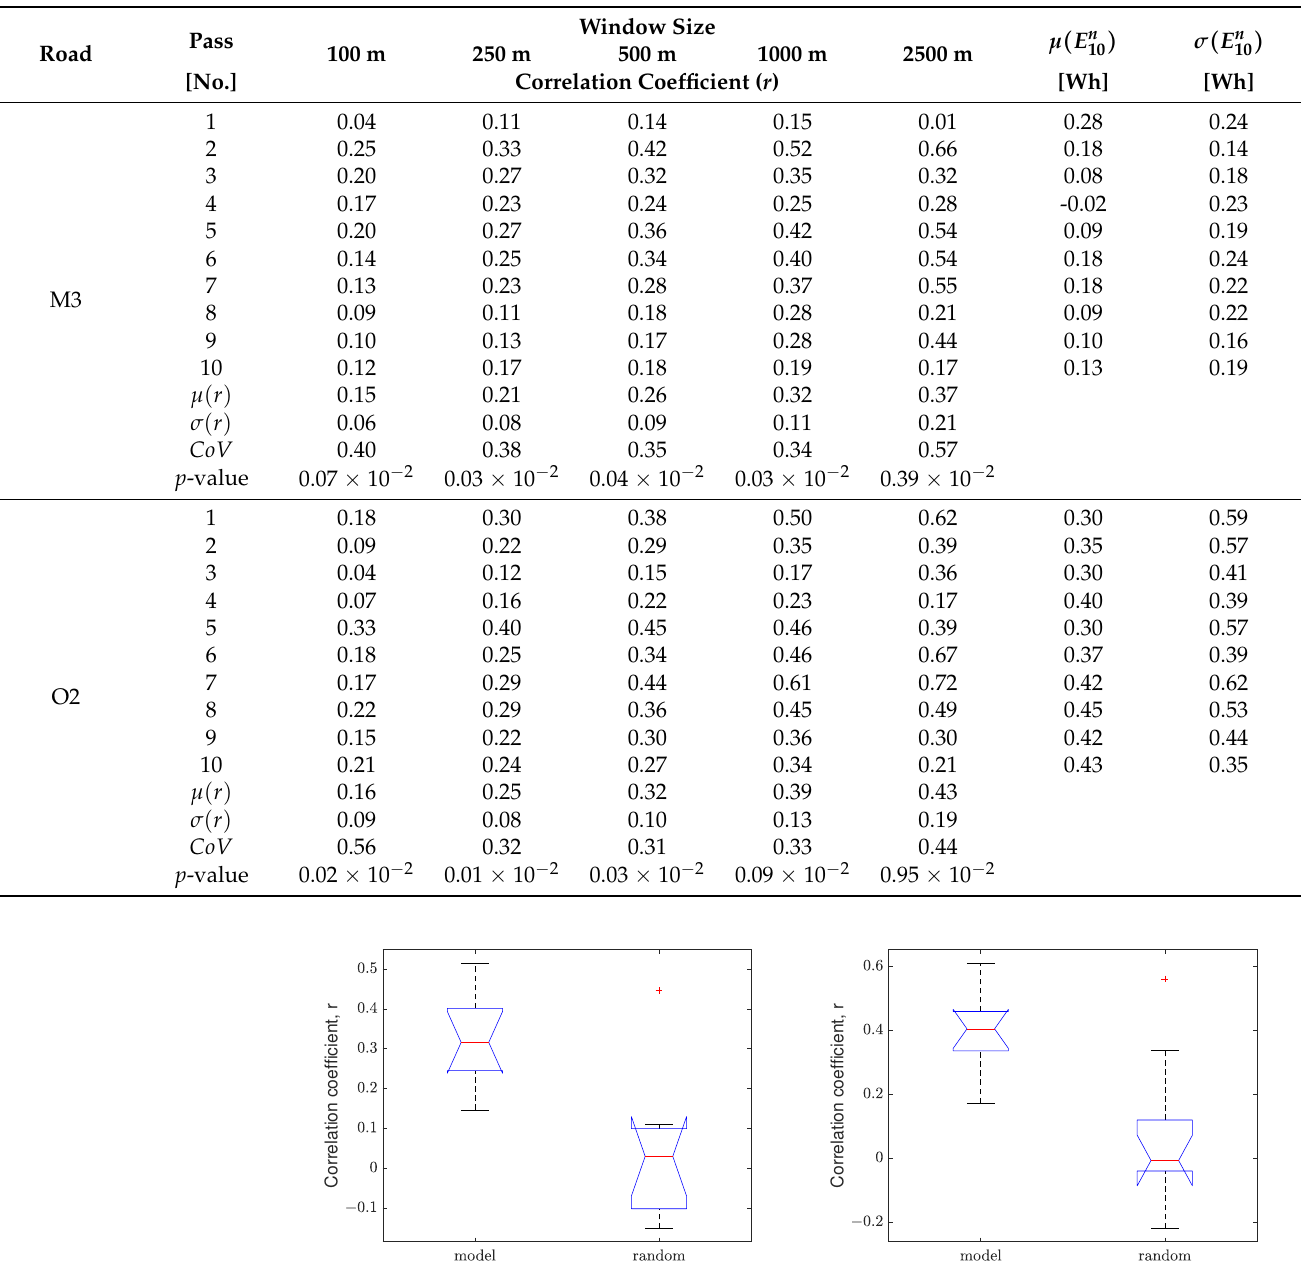
Table 8. Summary of correlations between normalized energy consumption and road roughness for individual vehicle passes.